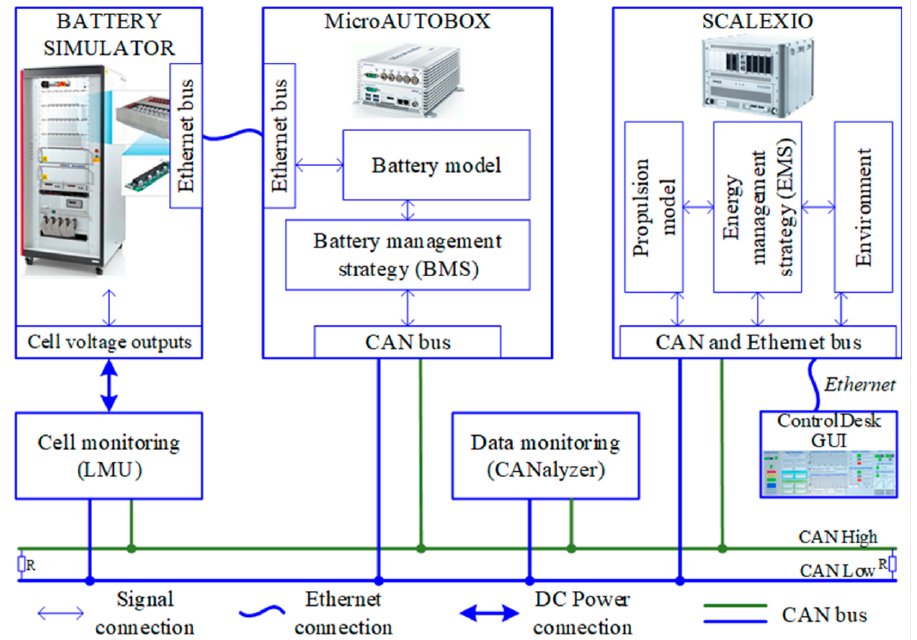
Figure 10. HIL platform communication block